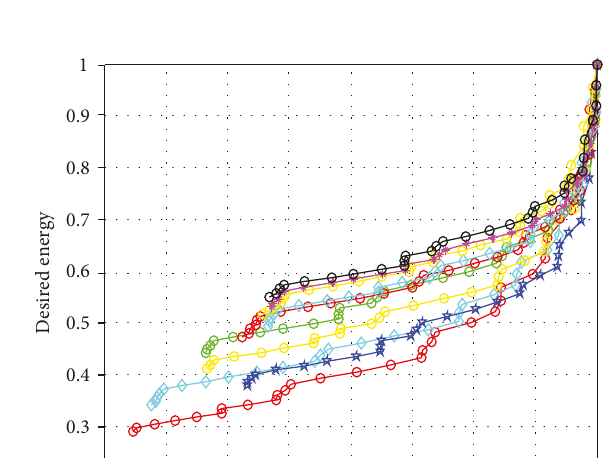
Figure 13: AECF variation.